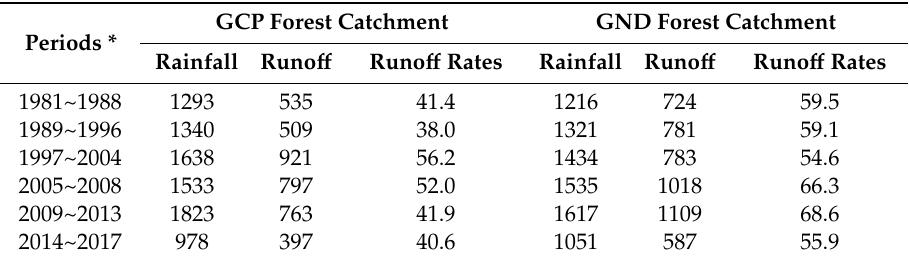
Table 3. Rainfall-runo ff characteristics in GCP and GND forest catchments.